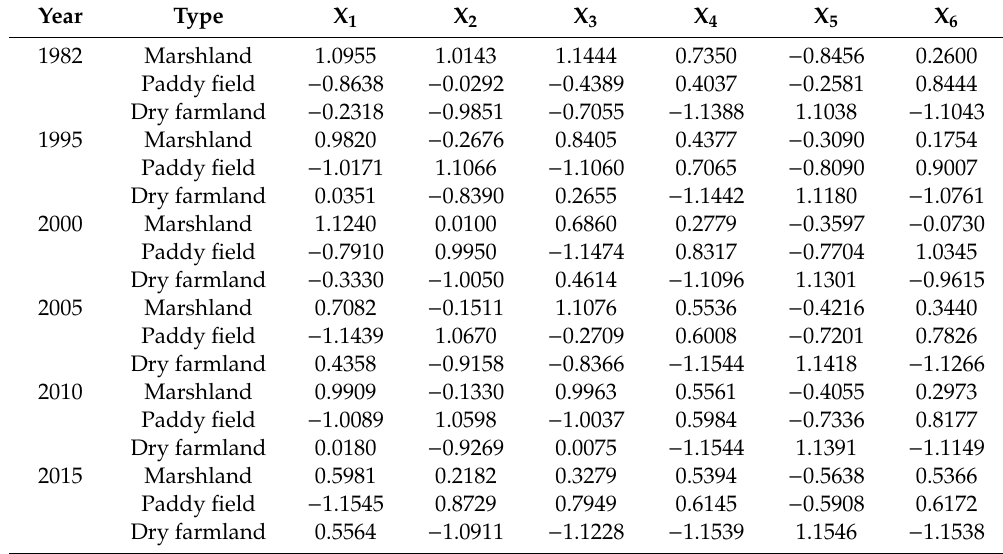
Table 5. The standard matrix for landscape type stability indices.